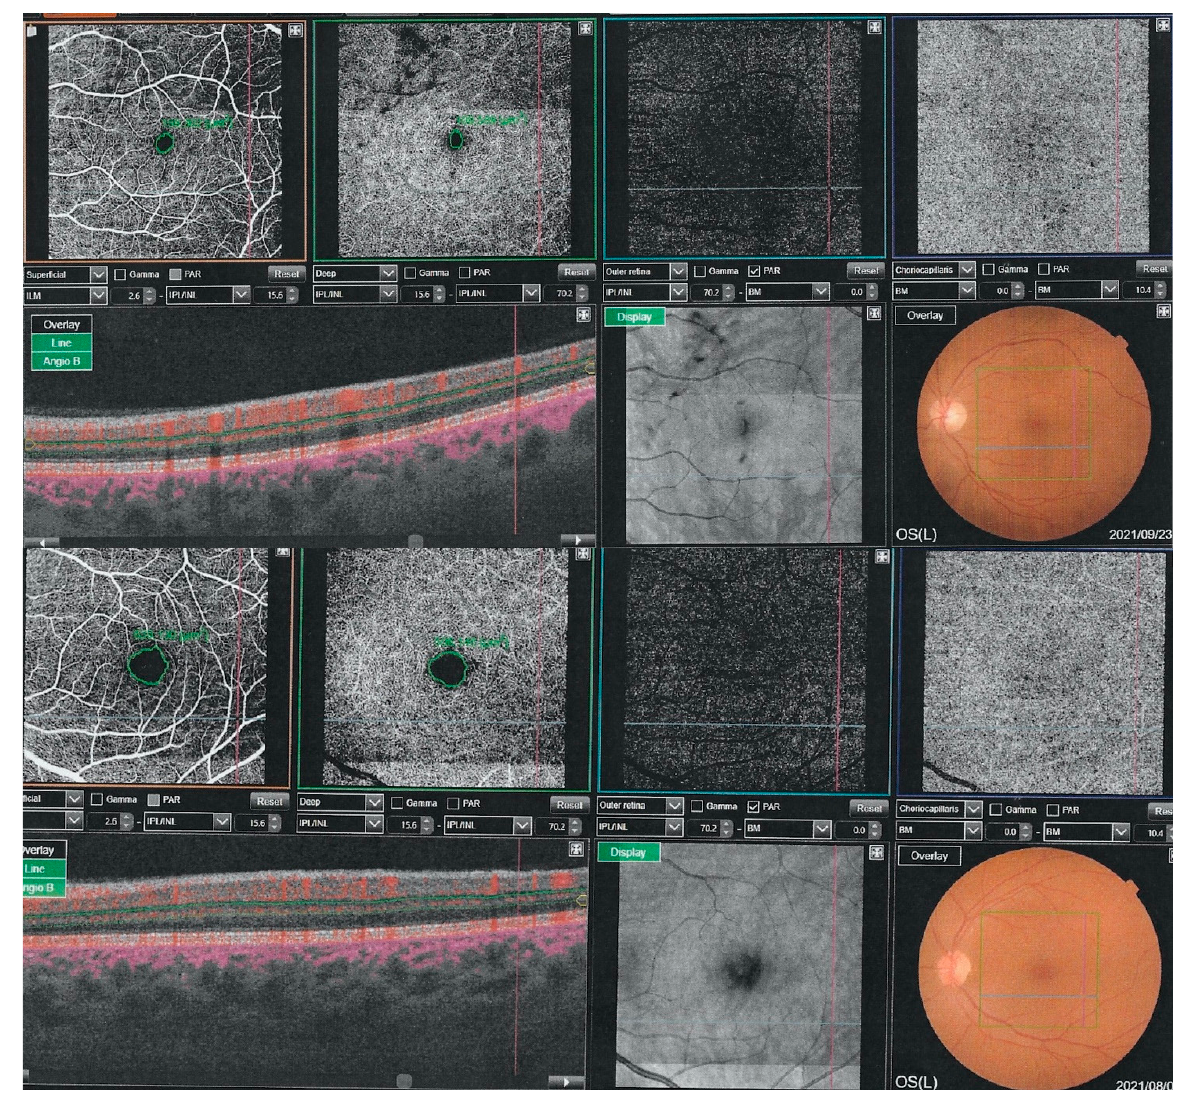
Figure 2. Representative image of the foveal avascular zone (FAZ) visible on the OCT in the control group (upper image) and the COVID-19 group (lower image). FAZ enlargement can be seen in the COVID-19 group. Table 3. Comparison of the foveal area in the superficial (SCP), deep capillary plexus (DCP),